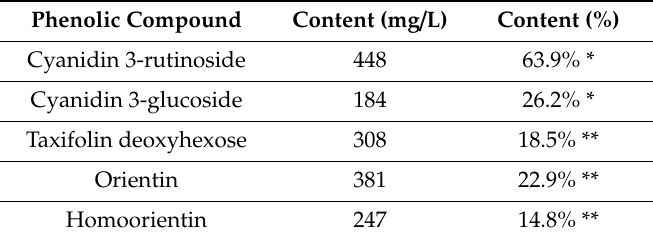
Table 1. Major phenolic compounds of the Euterpe oleracea